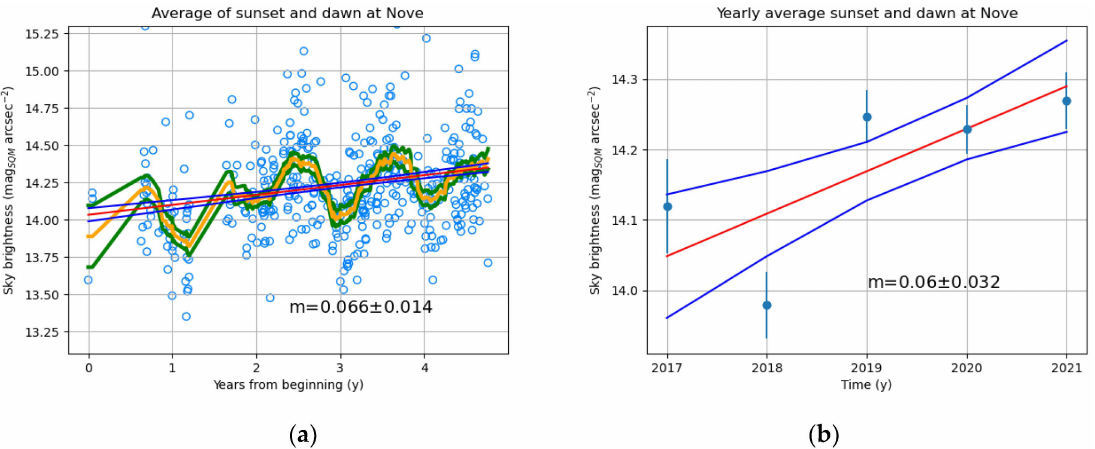
Figure 8. Trends of the sky brightness at zenith at Nove: average values at sunset and dawn ( a ) with their moving average (yellow curve) and aside the green curves accounting for one standard deviation ( a ) and the annual average values ( b ) when the Sun altitude is around − 6.5 ◦ , the red line is the linear fitting and the blue curves account for the uncertainty on the fitting